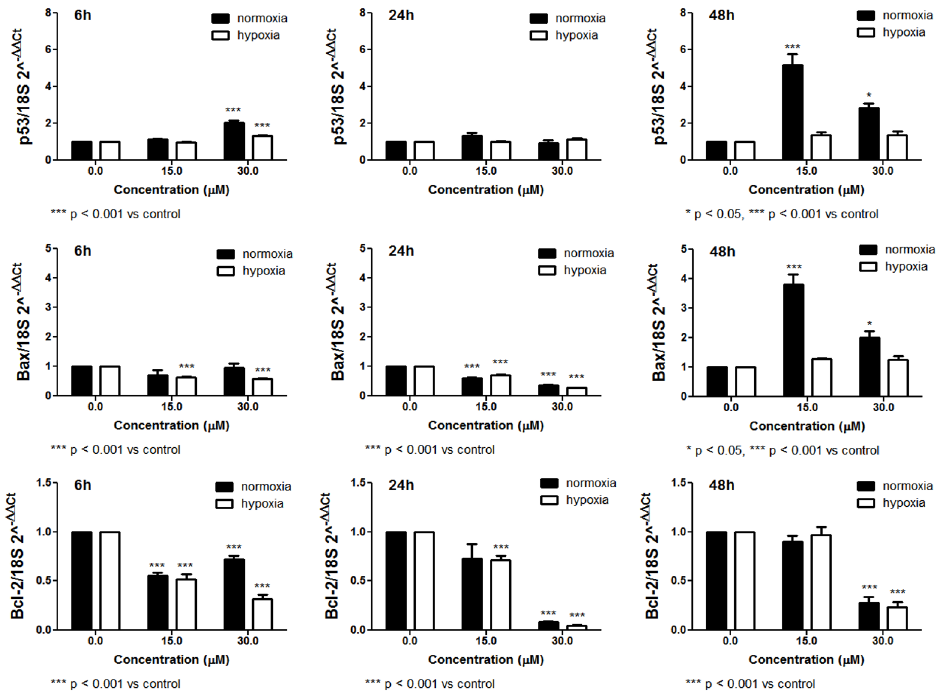
Figure 8. Effect of SR on p53, Bax and Bcl-2 mRNA relative expression calculated through the 2 - DD C t method and determined in normoxic and hypoxic conditions on REH cells. Cells were treated with 0 to 30 m M SR for 6, 24 or 48 h. Data are presented as mean 6 SEM of at least four different experiments.